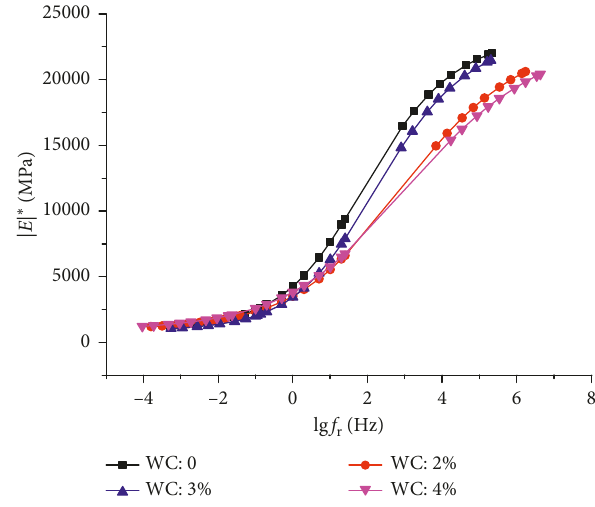
Figure 24: SBS#AC-13-type dynamic modulus main Table 6: Dynamic modulus master curve parameters and shift factor of warm mix foamed asphalt mixture at 20 ° C. Type